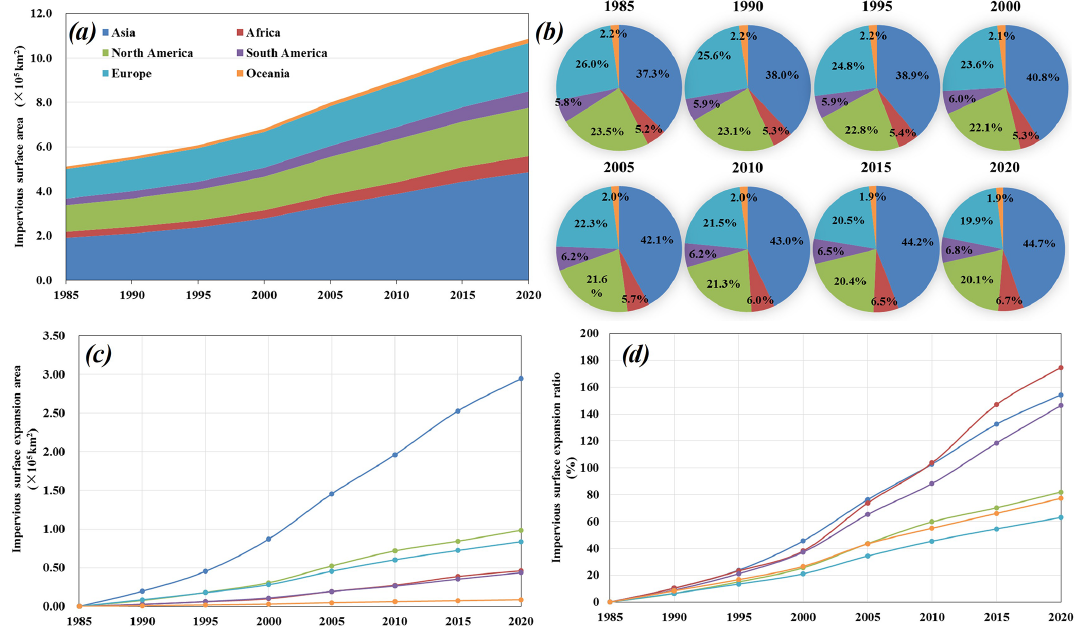
Figure 6. The expansion of impervious surfaces on each continent over the period of 1985–2020. (a) The impervious areas of six continents in each period. (b) The proportion of impervious areas on six continents from 1985 to 2020. (c, d) The increased impervious area and corresponding expansion ratio on each continent.